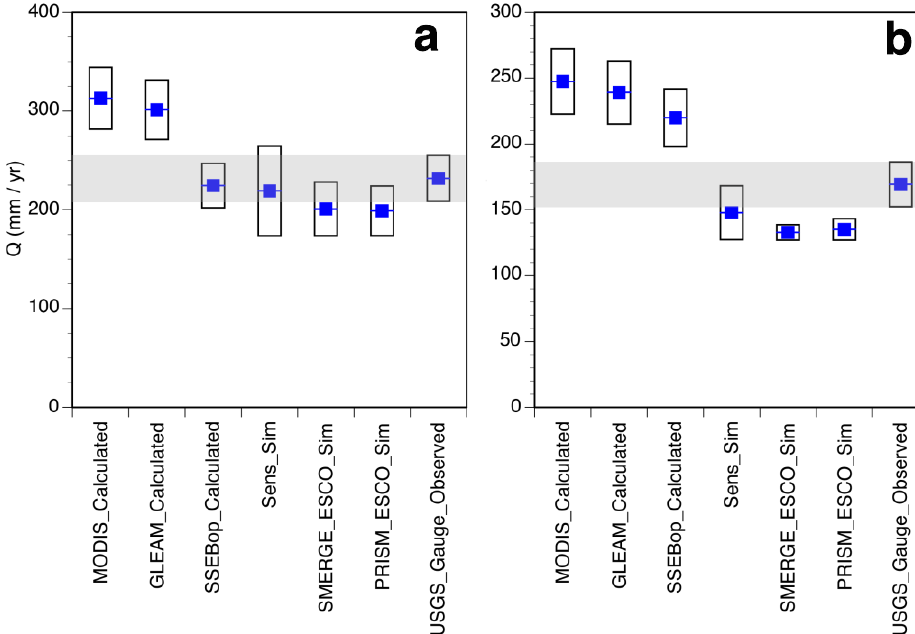
Figure 8. Same as Figure 5. ( a ) LN-2016, and ( b ) LN-2017.